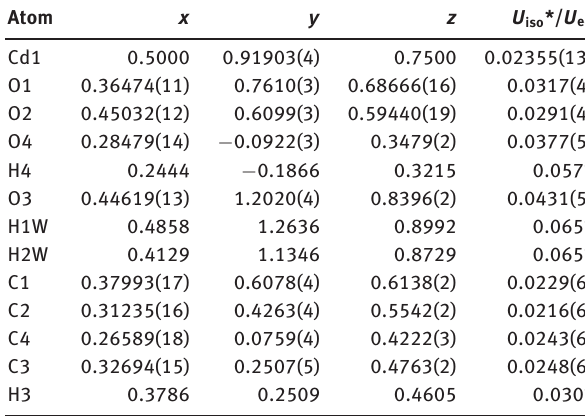
Table 2: Fractional atomic coordinates and isotropic or equivalent isotropic displacement parameters (Å 2